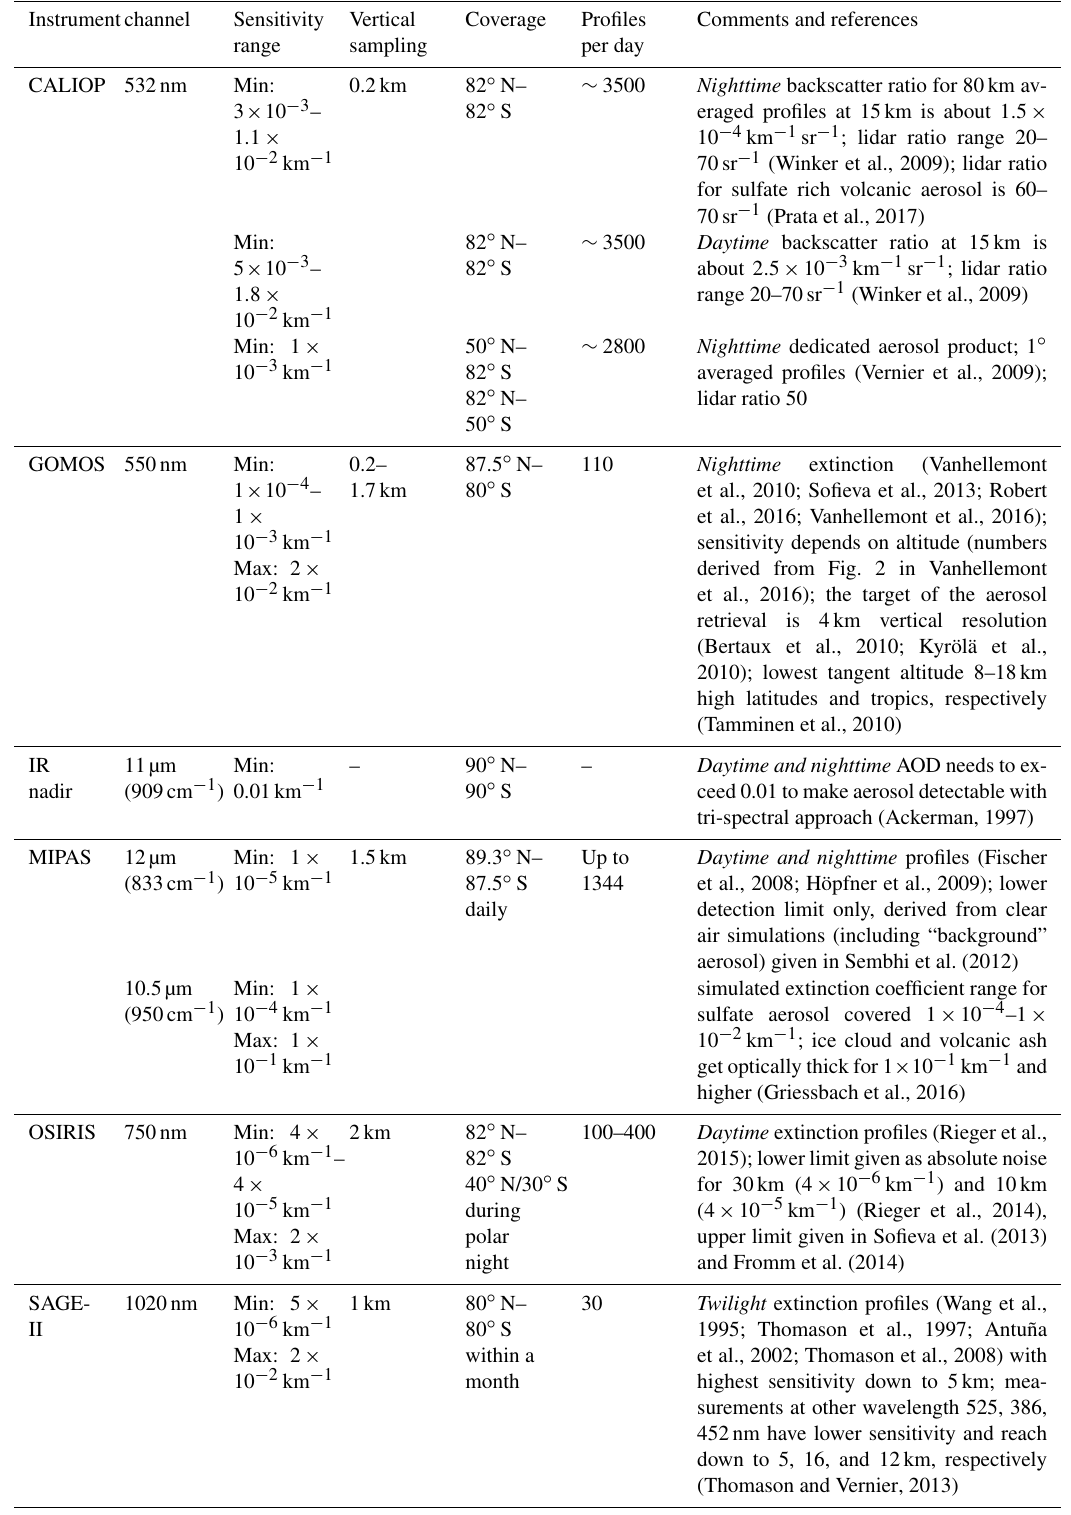
Table 1. Overview of relevant instrument characteristics for global aerosol measurements. The minimum detection sensitivity is given for the listed wavelength. The maximum sensitivity indicates the point when the measurements run into saturation, i.e. the top of thicker clouds is always detectable. In the comments column the references are also